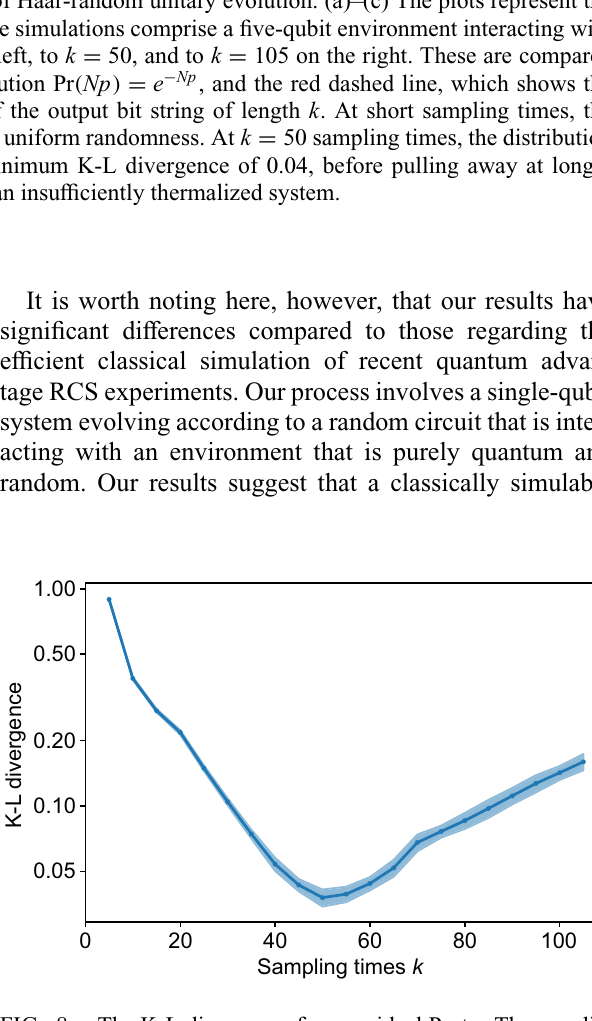
FIG. 8. The K-L divergence from an ideal Porter-Thomas dis- tribution for Haar-random unitary evolution. The K-L divergence for sampling times k = 5 to k = 105 is shown for simulations of a five-qubit environment interacting with a single-qubit system. Each data point is the average of 30 simulations of the process for the specified sampling time. The shaded region represents the standard deviation. For each of these simulations, we repeat our circuit 10 000 times to compute the probability density function. The average minimum K-L divergence is 0.0378 for k =